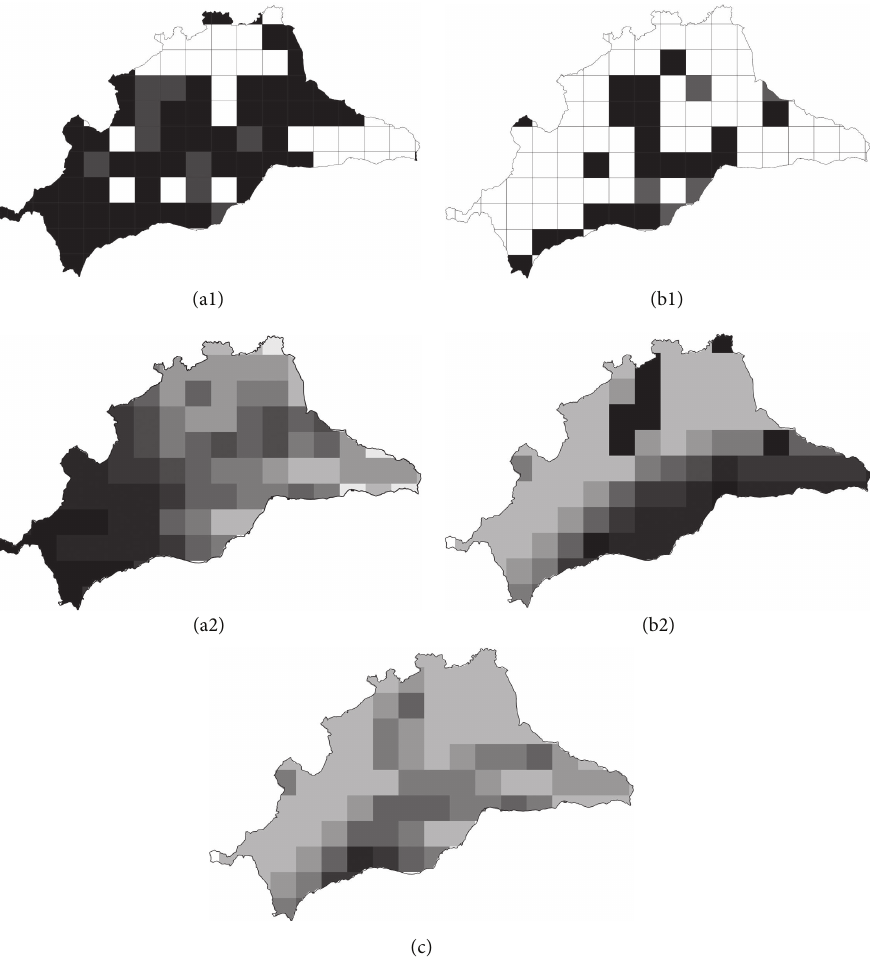
Figure 2: Maps (a1) and (b1) show the distribution of both species in M´alaga. Filled cells show the presence of Mauremys leprosa in (a1) and of Trachemys scripta in (b1). Black cells correspond to presences taken from Pleguezuelos et al. [15], and gray cells represent presences found during a more recent survey [7]. Maps (a2) and (b2) show the F - Mauremys -Ecogeographical model and F - Trachemys -Encroachment model, respectively. Map (c) shows the intersection between the favourability of both species. Shading ranges from white to black, where white indicates completely unfavourable areas (0) and black indicates completely favourable areas (1). Table2:Comparativeassessmentofthemodelsdevelopedto Mauremysleprosa and Trachemys scripta accordingtoclassification,discrimina- tion, and parsimony